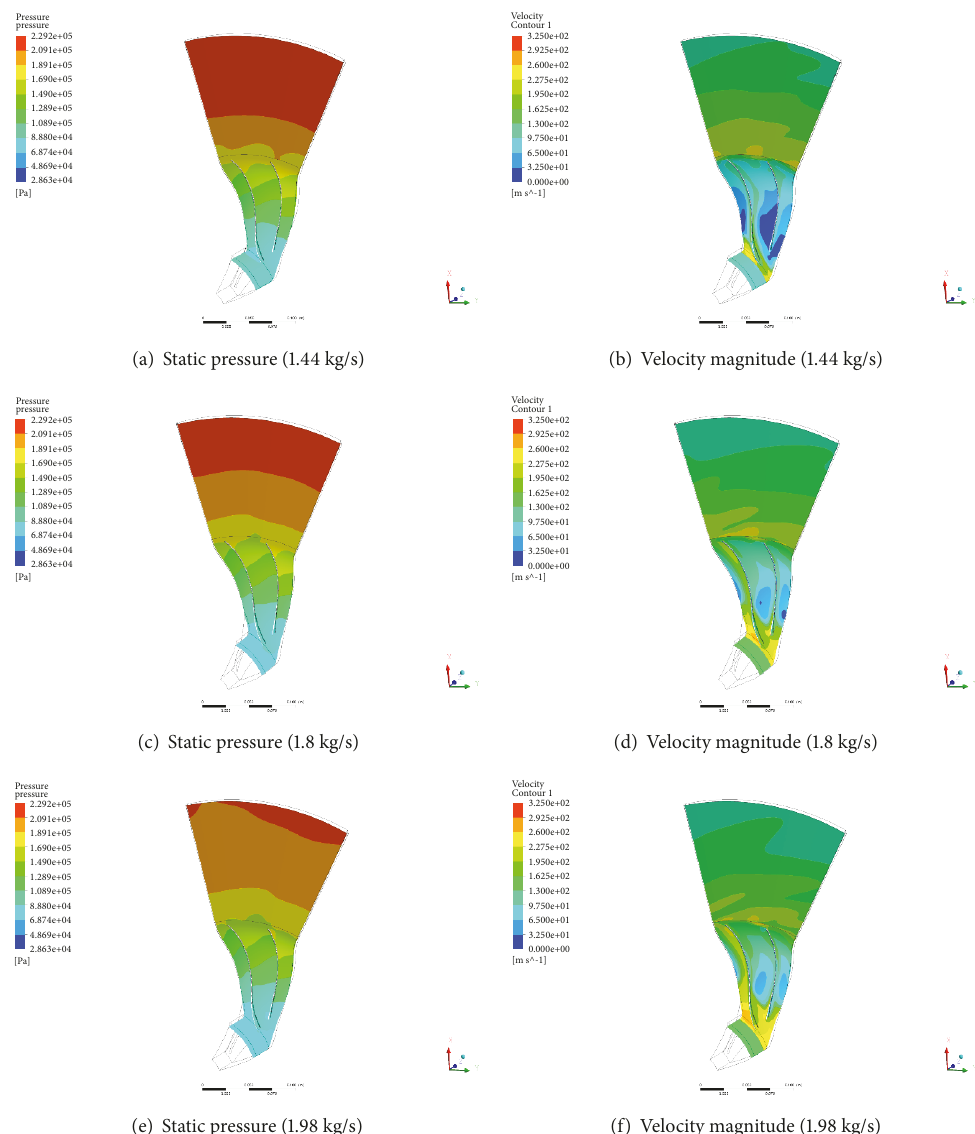
Figure 13: Static pressure and velocity magnitude contours at 461